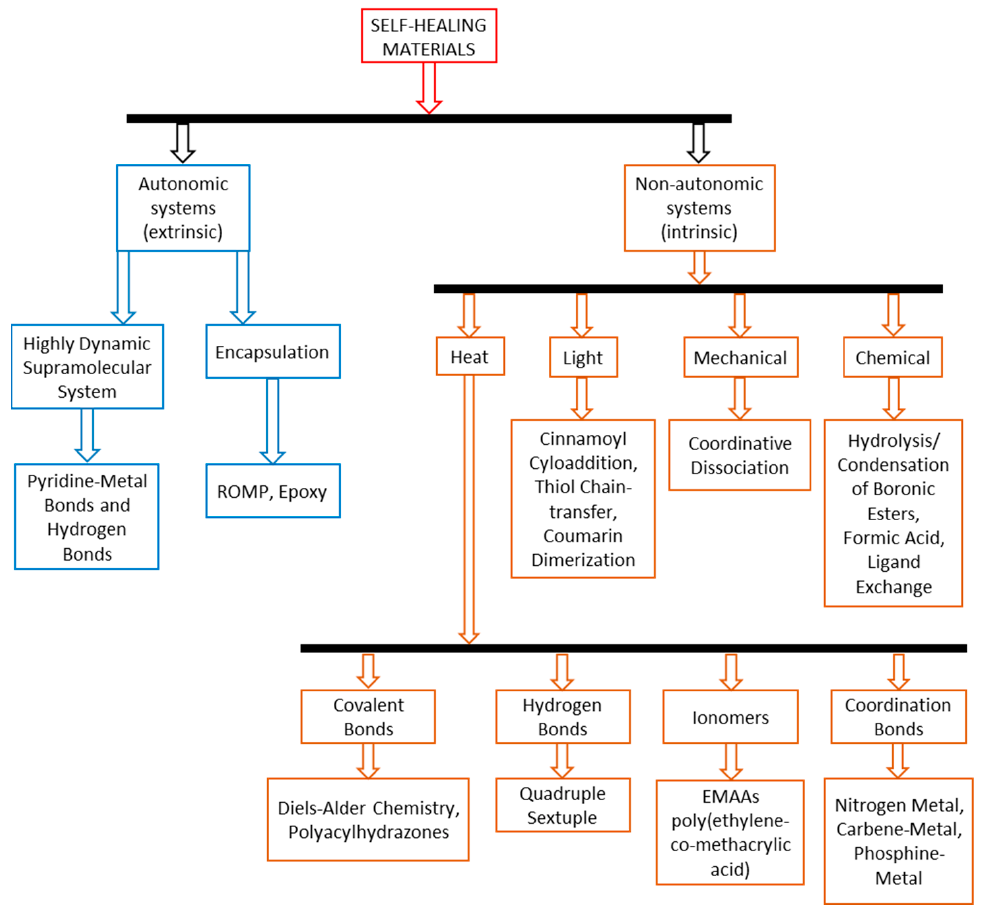
Figure 1. Polymer material classification with respect to their healing chemistry: autonomic self-healing systems and non-autonomic systems (adapted from [7]). Table 1. Overview of materials that can be used as healing agents and their respective delivery system. Delivery System Catalyst Used in FRP Healing Agent Required DCPD /